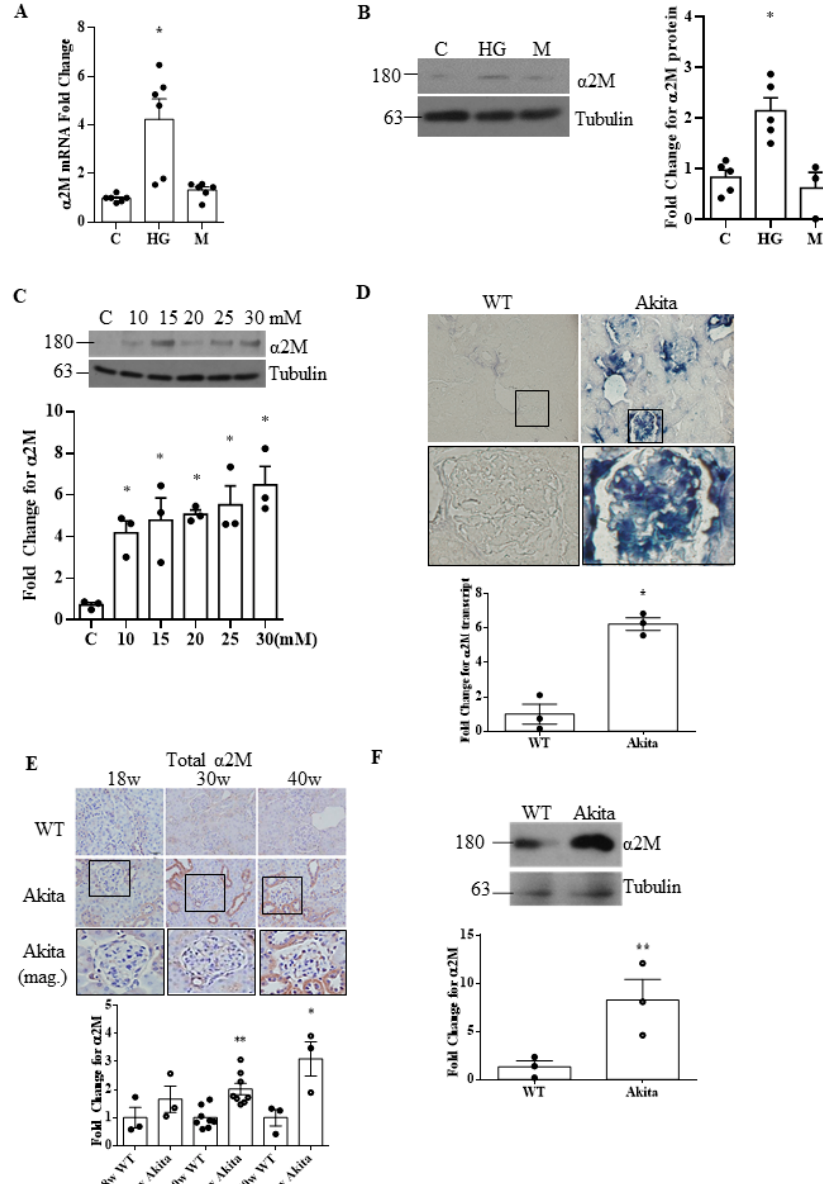
Figure 1. α 2M is increased by HG in mesangial cells and in diabetic kidneys. HG increased α 2M mRNA (24 h) ( A ) and protein (48 h) ( B ) expression in MCs. No effect was seen with the osmotic control mannitol (M) ( A : n = 6; B : n = 5) (* p < 0.01 vs. others). ( C ) α 2M expression increased dose-dependently with HG (24 h) concentrations from 10 to 30 mM ( n = 3, * p < 0.01 vs. con). ( D ) α 2M transcript expression, assessed by ISH, was significantly higher in type 1 diabetic Akita kidney sections compared to wild-type mice at 40 weeks of age (40× magnification, n = 3) (* p < 0.01 vs. control). ( E ) α 2M protein expression, as assessed by IHC, was significantly higher in kidney sections of 30- and 40-week-old type 1 diabetic Akita mice compared to wild-type mice (40× magnification, n = 10). ( F ) This was also seen by immunoblotting of kidney lysate from 40-week-old Akita compared to wild-type mice ( n = 3) (* p < 0.01 or ** p < 0.05 vs. respective control).